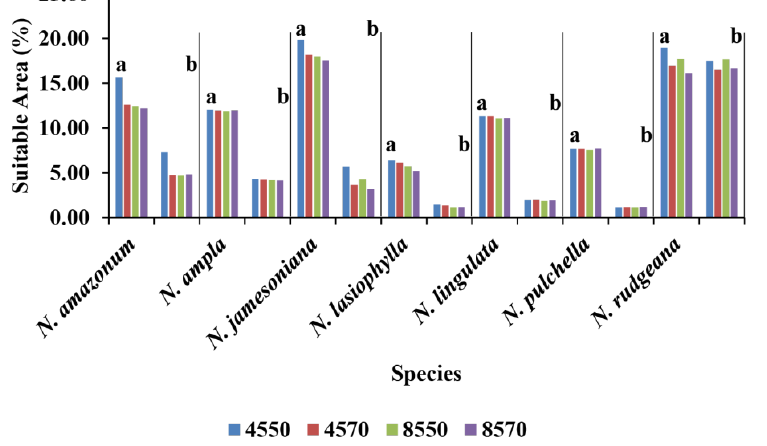
Figure 5. Comparison of habitat suitability change for the water lily species within unprotected areas (a) and protected areas (b). Change area is represented in percentage, expansion in positive values, and contraction in negative values.